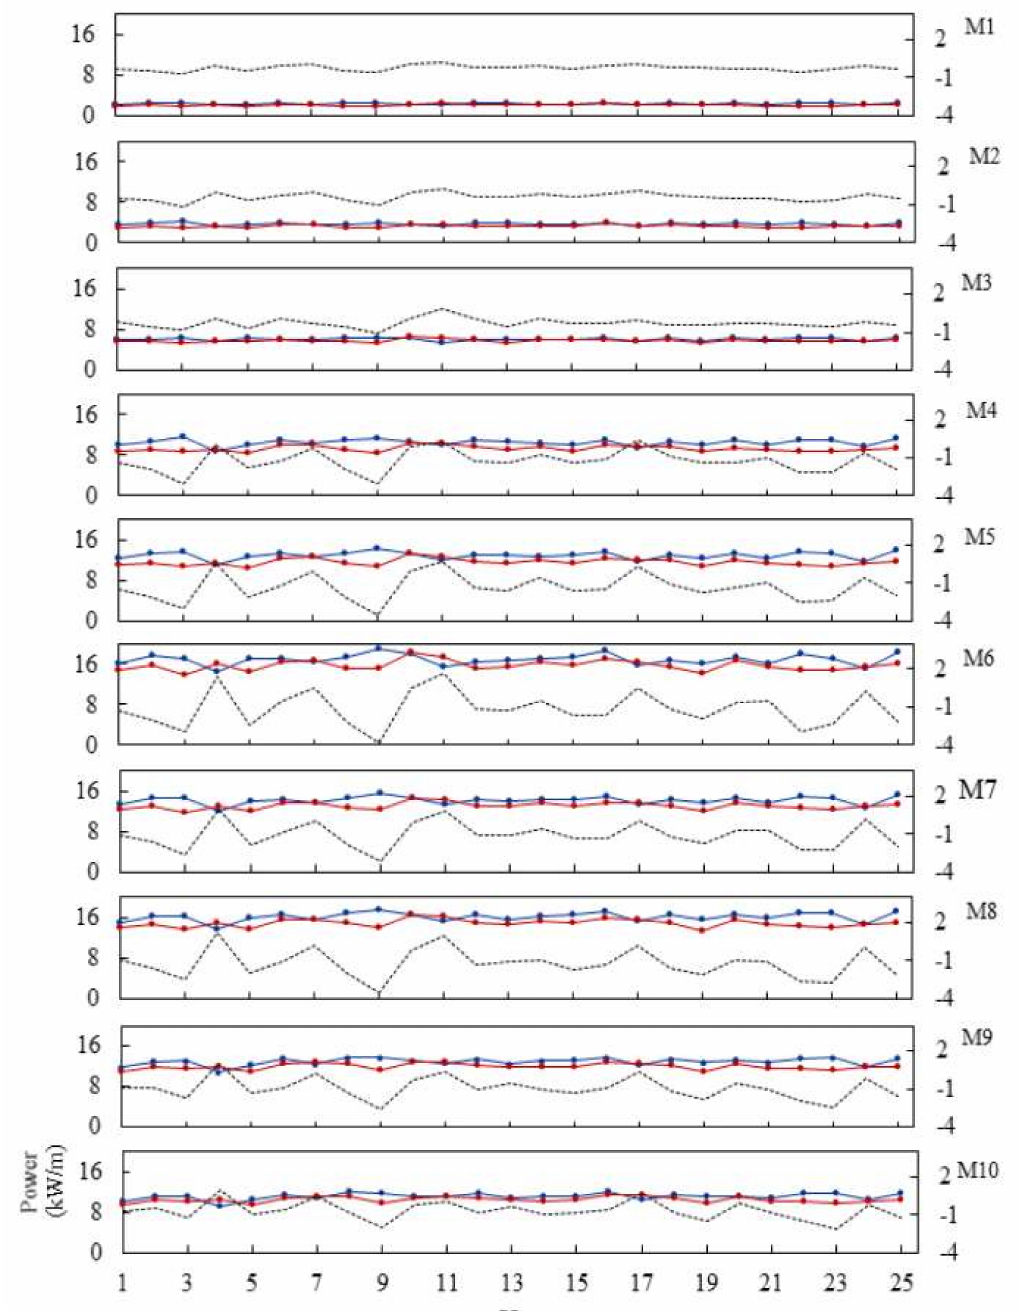
Figure 8. Present (blue) and future (red) annual average wave power at M1 to M10 during the 25-year simulation period around. X -axis gives the year number, staring from the beginning of the “present (1979)” and “future (2075)” 25-year simulation time slices. Secondary axis corresponds to the di ff erence between available power in the present and future (broken